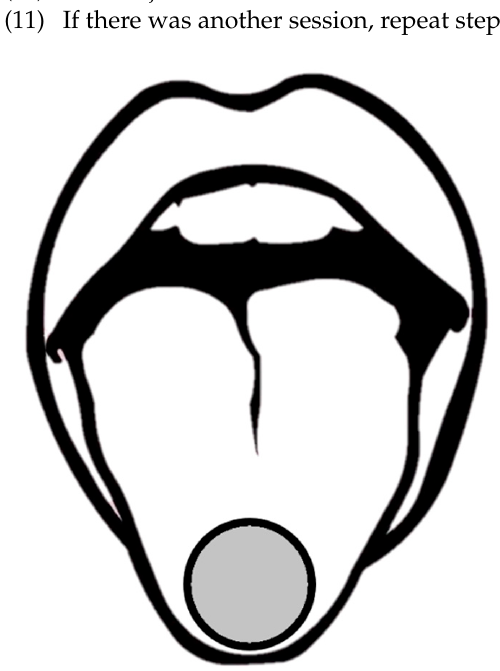
Figure 3. The position of stimulus coverage.